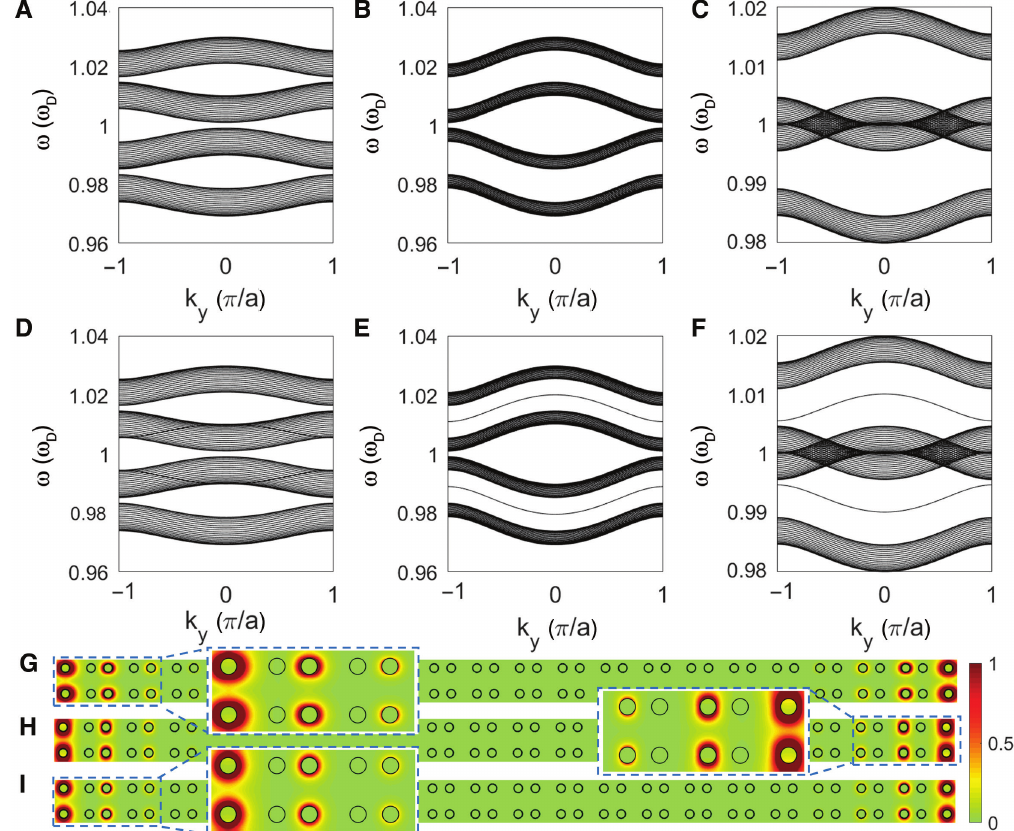
Figure 2: Edge states dispersion and field profile. (A–F) Projected bulk states and edge states of 20 unit cells aligned along x -axis. Left, center, and right column correspond to x -, y -, and z -polarized modes, respectively. (A–C) R modes